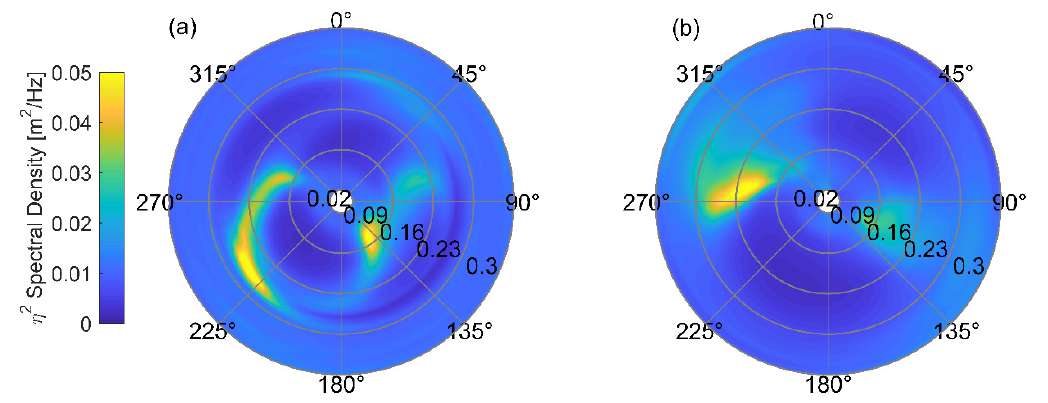
Figure 3. Averaged sea surface variance directional spectral density from instruments ( a ) CWTb1 and ( b ) CW4. Table 3. Occurrence of peak wave direction from each station. Occurrence is presented in percentages and directions represent the direction the waves are coming from.